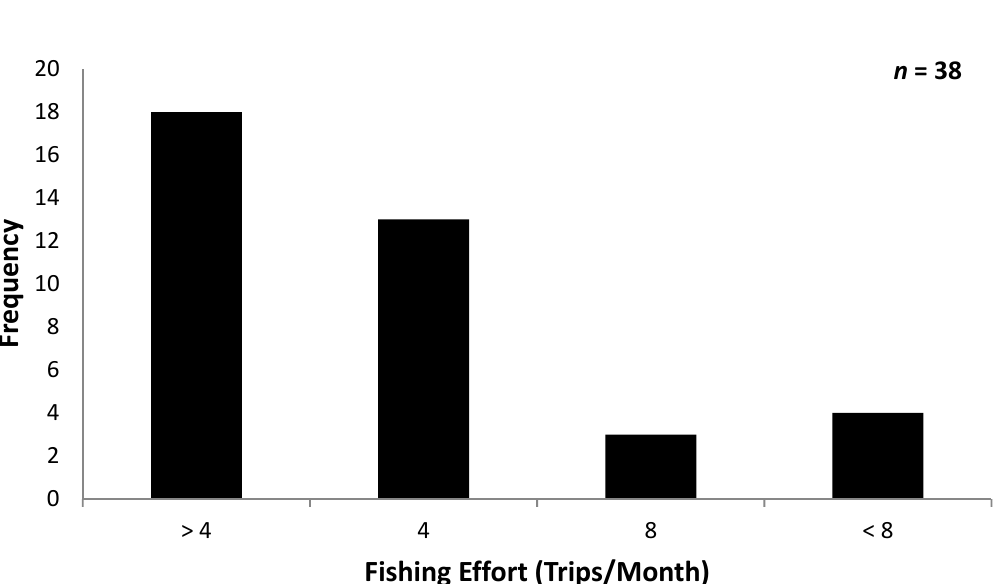
Figure 5. Recreational swordfish fishing effort off Southeast Florida.